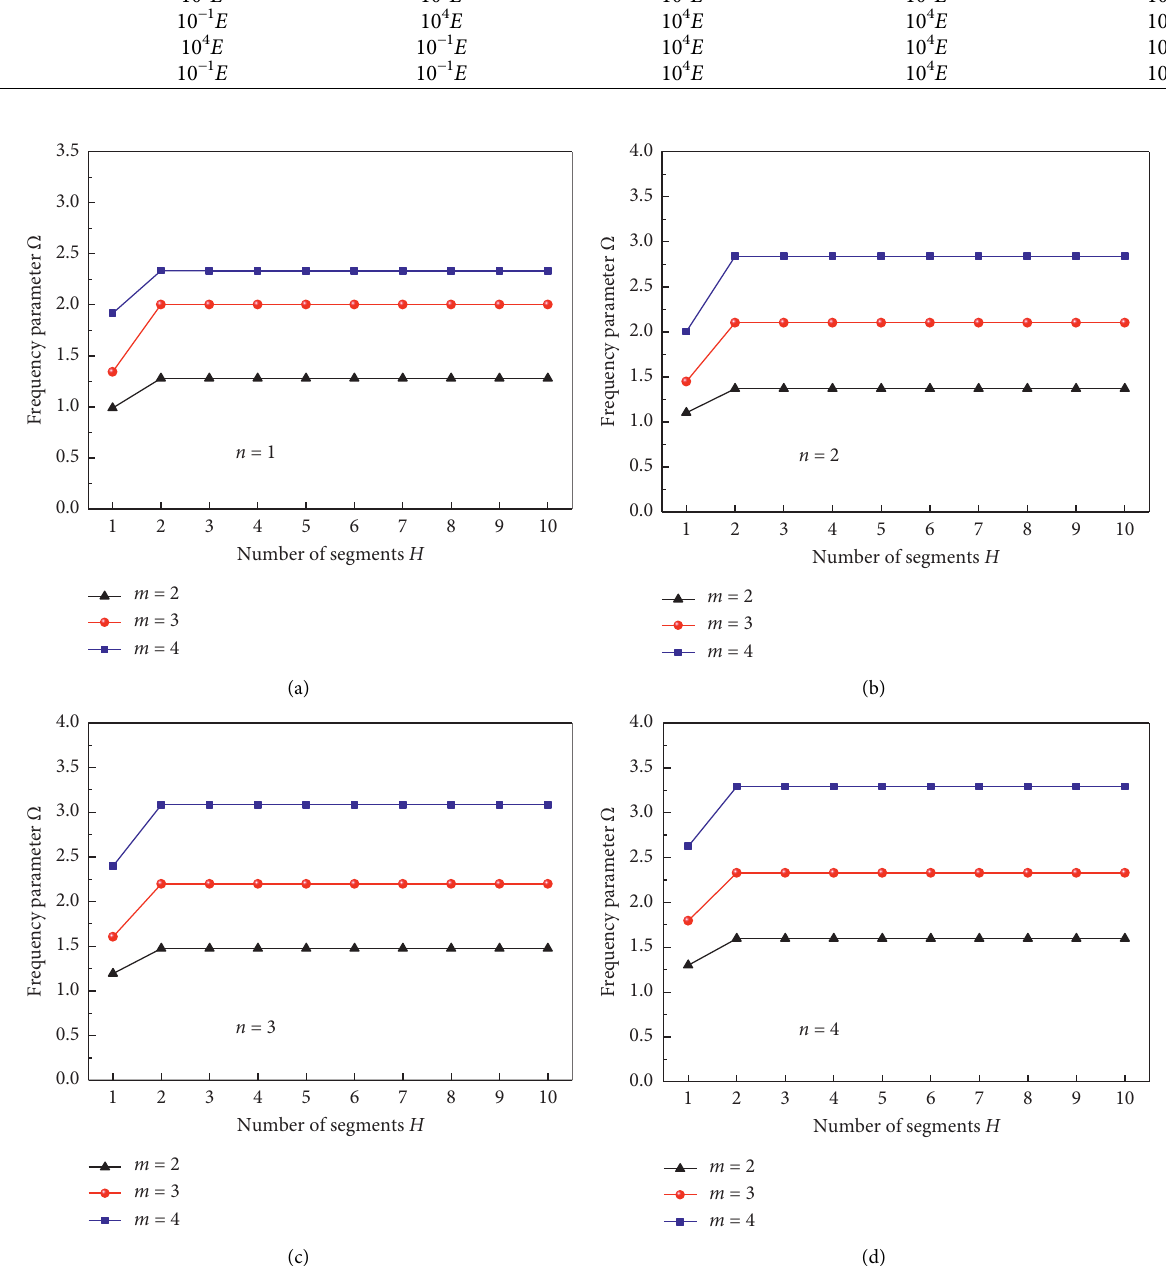
Figure 3: Frequency parameters Ω of the annular spherical shell with different number of